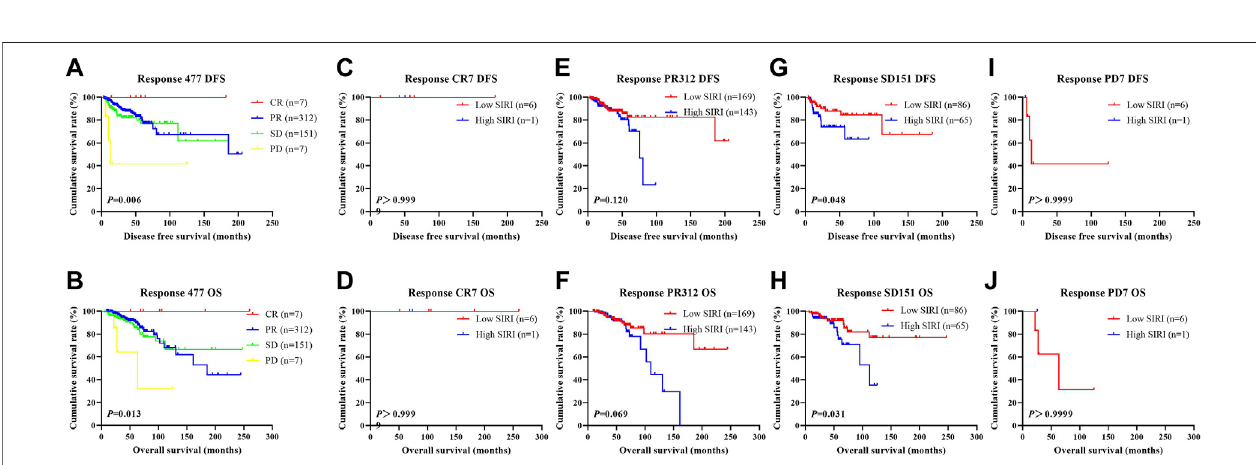
FIGURE 10| DFS and OS derived from responseto neoadjuvant chemotherapy inbreast cancer patient who received NACT. DFS and OS derived from response toneoadjuvantchemotherapyinbreastcancerpatientwhoreceivedNACT. (A) Kaplan-MeieranalysisofDFSfortheSIRIofpatientswithbreastcancer. (B) Kaplan-Meier analysisofOSfortheSIRIofpatientswithbreastcancer. (C) Kaplan-MeieranalysisofDFSfortheSIRIofpatientswithbreastcancer. (D) Kaplan-MeieranalysisofOSfor the SIRI of patients with breast cancer. (E) Kaplan-Meier analysis of DFS for the SIRI of patients with breast cancer. (F) Kaplan-Meier analysis of OS for the SIRI of patients with breast cancer. (G) Kaplan-Meier analysis of DFS for the SIRI of patients with breast cancer. (H) Kaplan-Meier analysis of OS for the SIRI of patients with breast cancer. (I) Kaplan-Meier analysis of DFS for the SIRI of patients with breast cancer. (J) Kaplan-Meier analysis of OS for the SIRI of patients with breast cancer.